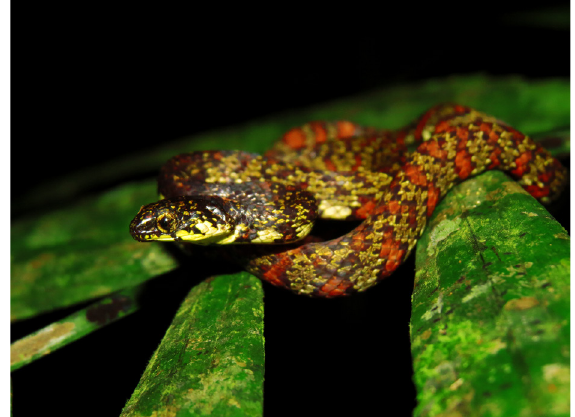
Figure 5. New country record of Sibon argus. Finca La Boga, vereda Bedó, municipality of Mutatá, Antioquia Department. Picture by Carlos Mario